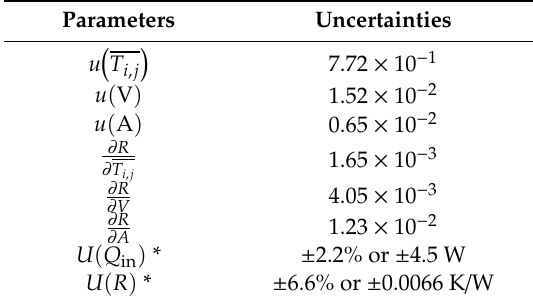
Table 2. The uncertainties and sensitivity coefficient of parameters, Q in = 200 W.